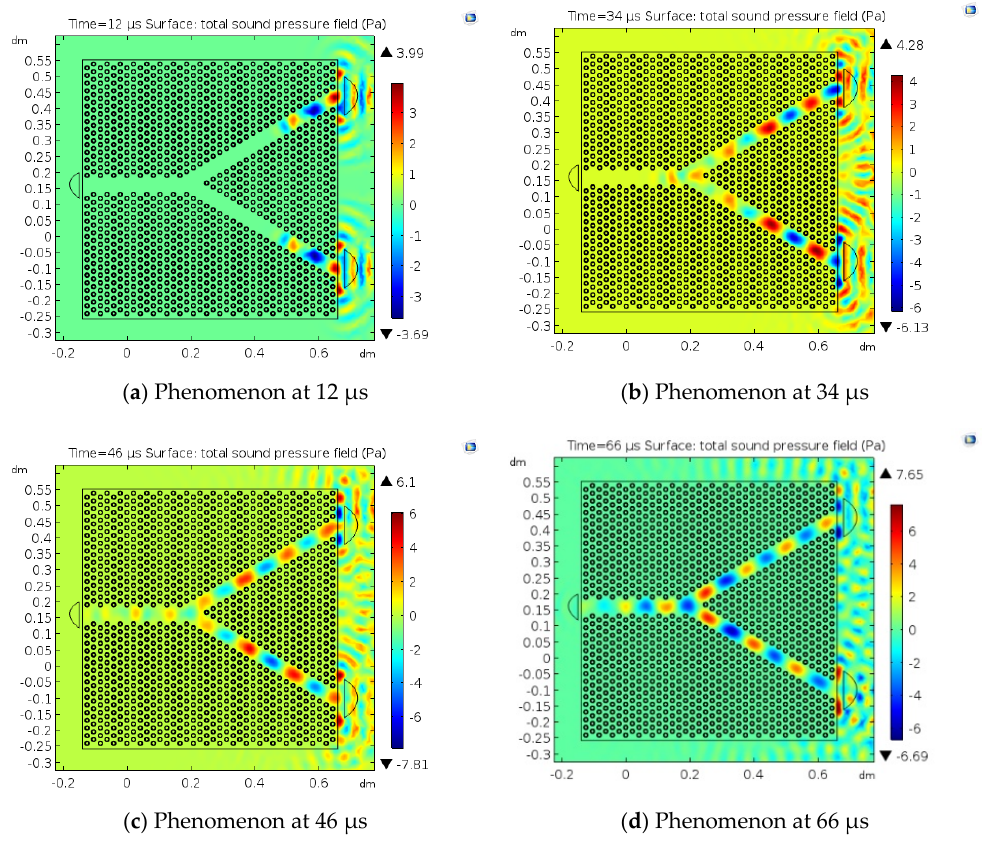
Figure 8. Filtering effect of fixed-frequency sound wave: ( a ) Phenomenon at 12 µs; ( b ) phenomenon at 34 µs; ( c ) phenomenon at 46 µs; ( d ) phenomenon at 66 µs.